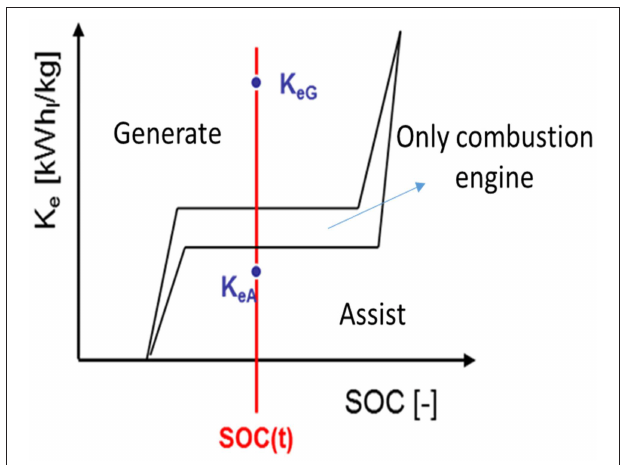
FIGURE 11 | STE curve for the hybrid control strategy in PHEM (Matzer et al., 2019).